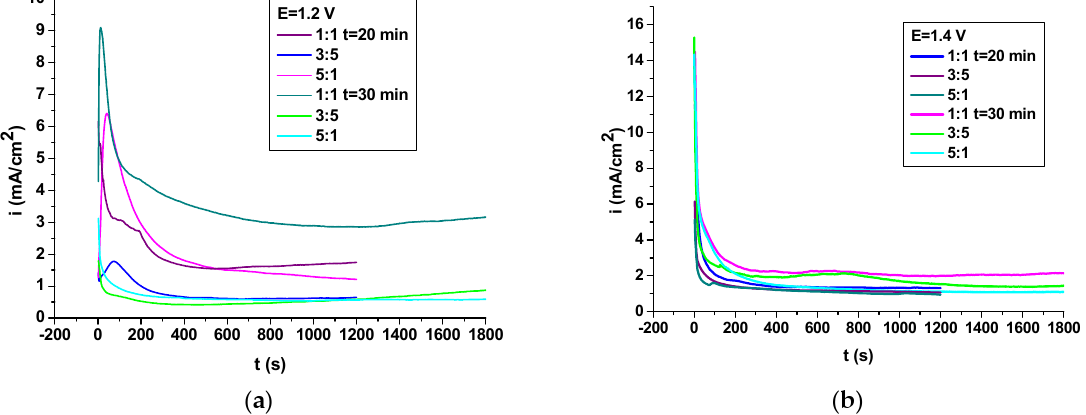
Figure 2. Potentiostatic depositions of PNMPY-TW20/P3MT OLC 45 at potential 1.2 V ( a ) and 1.4 V ( b ) vs. SCE for 1200-1800 s with different molar ratio for PNMPY-TW20 and P3MT. 3.2. Electrochemical Characterization of PNMPY-Tw20/P3MT Composite Coating OLC 45 sample in 0.3 M H 2 C 2 O 4 solution without a monomer is displayed in Figure 3 in